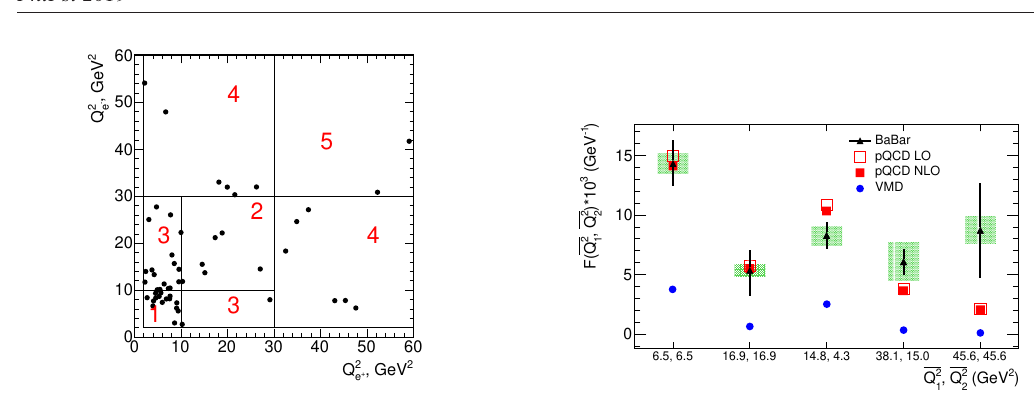
Figure 5. The Q 2 versus Q 2 distribution for data e + e − events. The lines and numbers indicate the five regions used for the study of the dynamics of TFF a function of Q 2 and Q 2 . e + e −